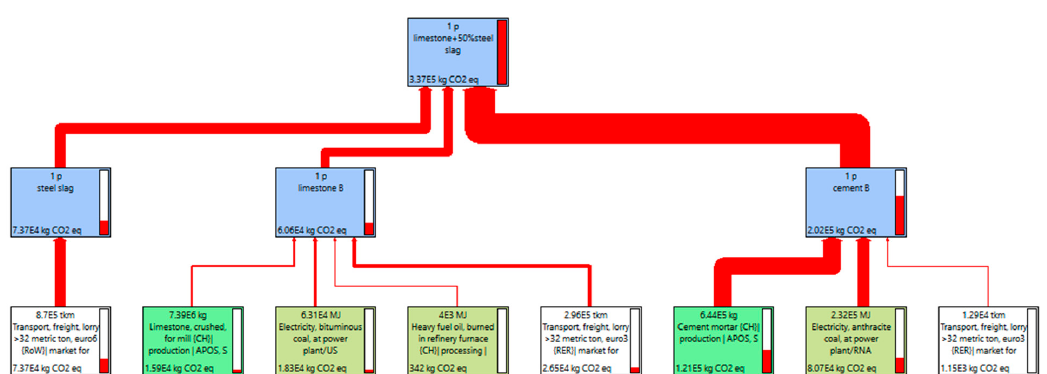
Figure 16. CO 2eq emission of 50% steel slag + 50% limestone with transport distance 100 km.